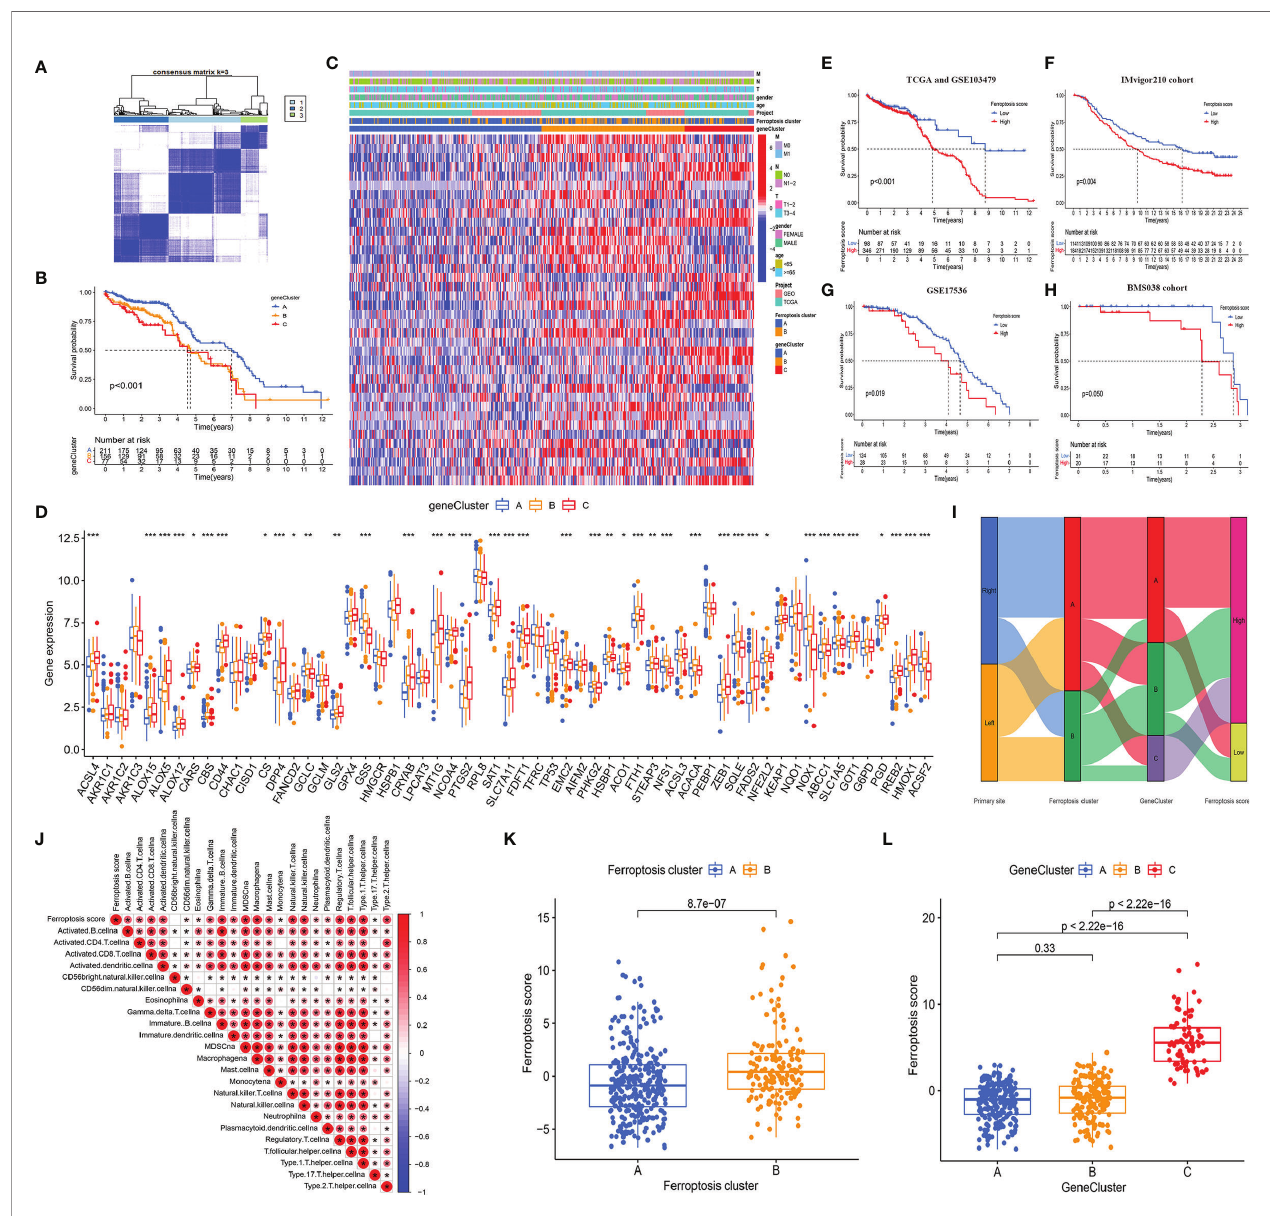
FIGURE 4 | (A) The consensus matrixes for TCGA-COAD cohorts based on the DEGs among the 2 ferroptosis clusters. TCGA samples were clustered into an appropriate number of subtypes (k = 3). (B) Kaplan – Meier curves showed an overall survival difference between gene clusters ( p < 0.001). (C) The heatmap shows the expression of the ferroptosis-related DEGs in different ferroptosis clusters and gene clusters. (D) The difference of FRG expression in normal and tumor tissues. The statistical difference was compared by the Kruskal – Wallis test (* p < 0.05, ** p < 0.01, *** p < 0.001). (E – H) Kaplan – Meier curves show overall survival difference between HSG and LSG in TCGA and GSE103479 cohort ( p < 0.001) (E) , IMvigor210 cohort ( p = 0.004) (F) , GSE17536 cohort ( p = 0.019) (G) , and BMS038 cohort ( p = 0.050) (H) . (I) The Sankey diagram demonstrates the distribution of patients with primary tumor sites, ferroptosis clusters, gene clusters, and FS. (J) Correlations between FS and the abundance of each ICI in TCGA cohort using Spearman ’ s analysis. Positive correlation with red and negative correlation is marked in blue. (K) Differences in FS between 2 ferroptosis clusters. The Wilcoxon test was used to compare the statistical difference between 2 ferroptosis clusters ( p < 0.001). (L) Differences in FS among 3 gene clusters. The Kruskal – Wallis test was used to compare the statistical difference between 3 gene clusters. DEGs, differentially expressed genes; TCGA, The Cancer Genome Atlas; FRG, ferroptosis-related gene; HSG, high ferroptosis score group; LSG, low ferroptosis score group; FS, ferroptosis score; ICI, immune cell in fi